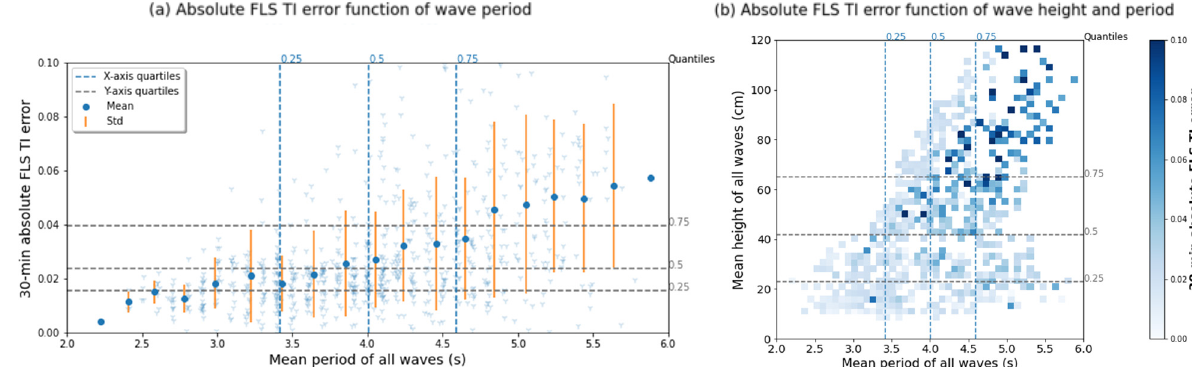
Figure 13. Distribution of the floating LIDAR TI absolute measurement error as a function of the 30-min wave statistics measured by the wave buoy. The turbulence intensity measurement error (absolute discrepancy) of the FLS is evaluated on the 10-min data in comparison to the fixed LIDAR at the altitude of 94.4 m. The 10-min data is averaged over 30 min for correlation with the 30-min wave statistics. Quartiles are displayed as dash lines for visualizing the statistical distribution of the data. ( a ) 30-min absolute FLS TI error as a function of the mean period of all waves. ( b ) Colormap of the 30-min absolute FLS TI measurement error with respect to the wave mean period and height.